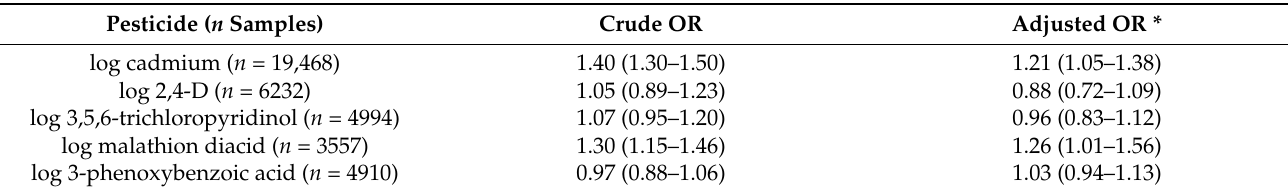
Table 2. Weighted logistic regression of pesticide exposures and low kidney function for participants in the National Health and Nutrition Examination Survey conducted in the US between 2001–2004 and 2007–2010. Pesticide ( n Samples) Crude OR Adjusted OR * log cadmium ( n = 19,468)